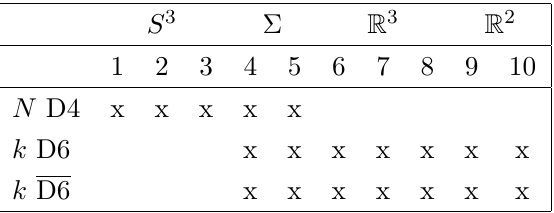
Table 2. Reduction of M-theory background to type IIA.